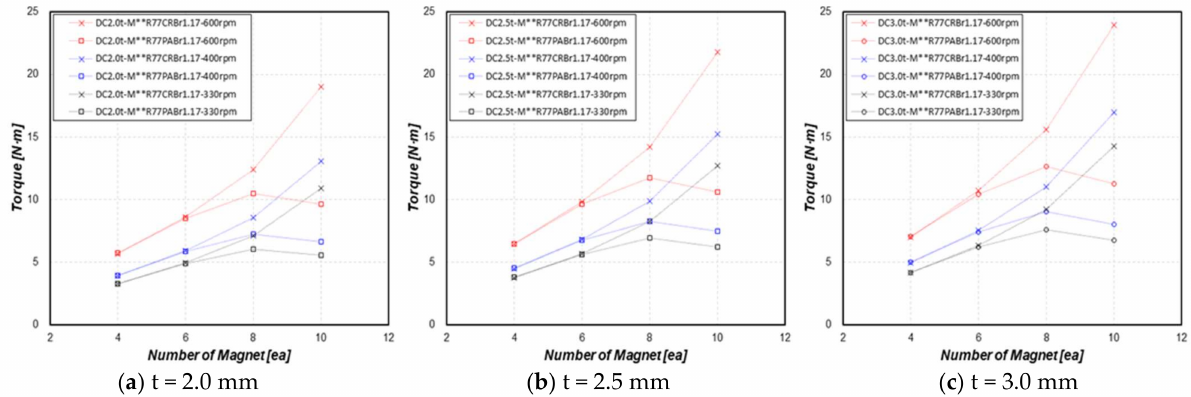
Figure 6. Torque vs. number of magnets plot.